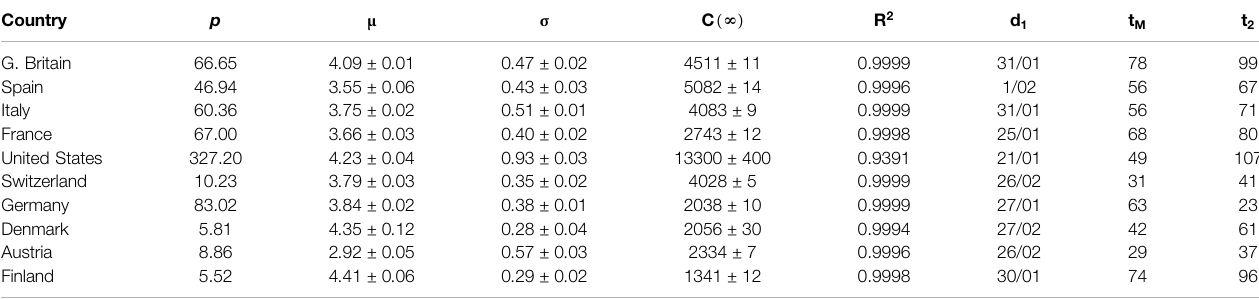
TABLE 2 | Parameters for SHR model (con fi rmed infections, fi rst wave). p : country ’ s population (millions). μ and σ : parameters in the lognormal distribution. C ( ∞ ) : asymptotic value for accumulated cases (per million person). R 2 and r 2 : R-squared correlation factors for C ( t ) and c ( t ) , respectively. t M and t 2 : maximum and second